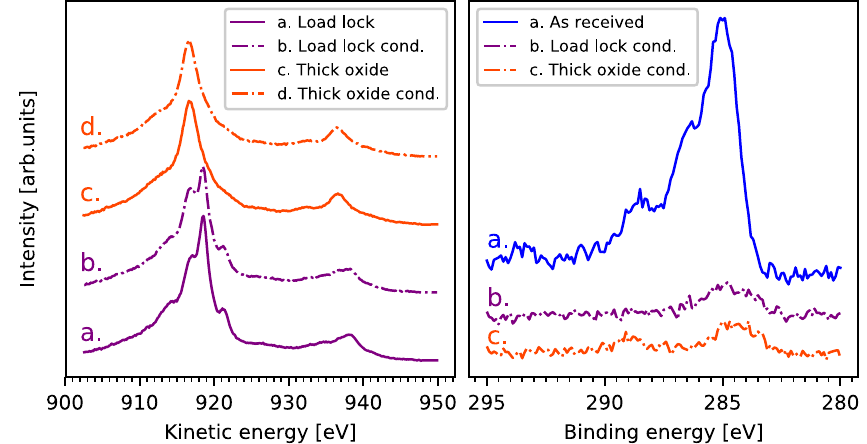
FIG. 6. (left) Cu LMM Auger lines of load lock and thick oxide samples, before and after conditioning, (right) C 1s lines of conditioned states for load lock and thick oxide samples. The C 1s line of the as received state of the load lock sample is given as a